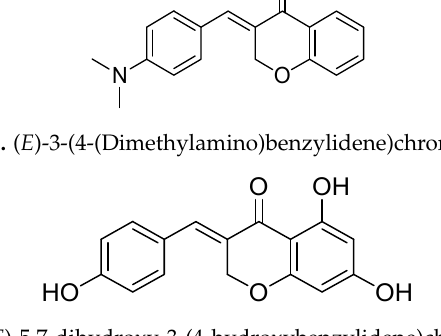
Figure 17. ( E Figure 17. ( E )-5,7-dihydroxy-3-(4-hydroxybenzylidene)chroman-4-one. Figure 17. ( E )-5,7-dihydroxy-3-(4-hydroxybenzylidene)chroman-4-one.